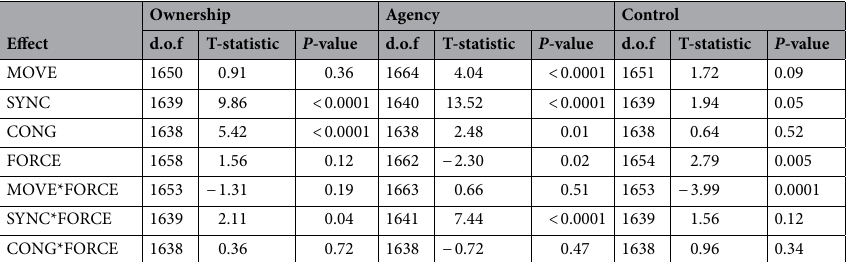
Table 2. Statistical results for Study II. SO ratings, SA ratings, control ratings and proprioceptive drifts (Study I only) are modelled as a function of the experimental factors ("movement type", "synchrony" and "congruency") and the